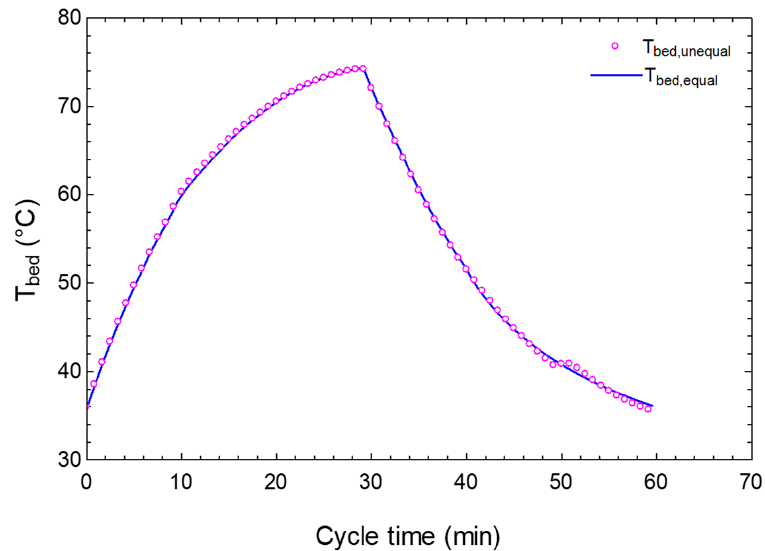
Figure 2. Bed temperature profile.